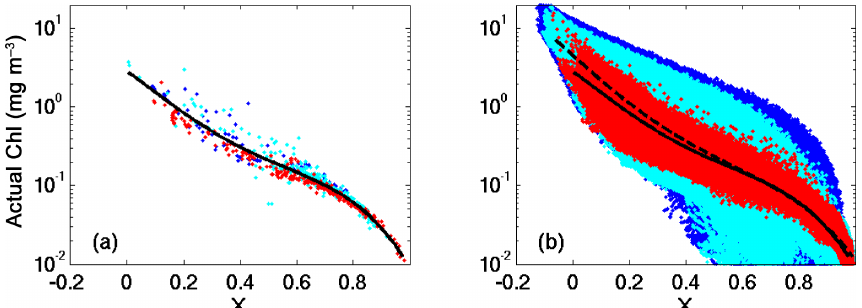
Figure 3. Model “actual” Chl a and model blue/green reflectance ratio ( X ) for (a) subset of model output similar to that available from real world in situ observations (e.g. NOMAD, Werdell and Bailey, 2005); (b) full model output (every day for 13 years from each grid cell, about 140 million points). The black solid line indicates the algorithm for chl d for where coefficients were determined from the subsampled datasets (GS), and in (b) the dashed line is the algorithm where coefficients were calculated using the full dataset (GA). Dots are coloured red for locations equatorward of 30 ◦ , light blue for 30 ◦ to 60 ◦ and dark blue for poleward of 60 ◦